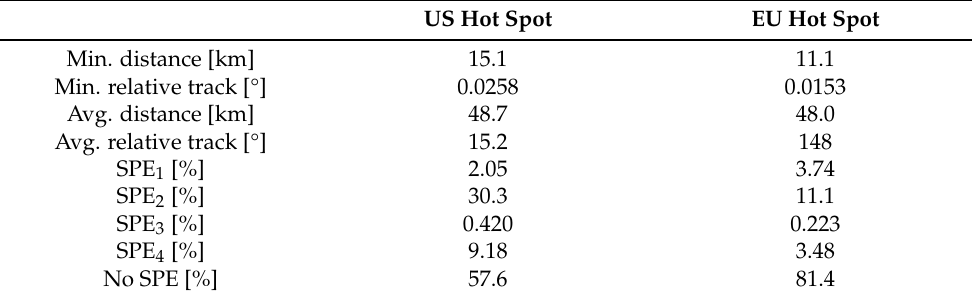
Table 1. Key information regarding significant plume encounters for both hot spots. US Hot Spot EU Hot